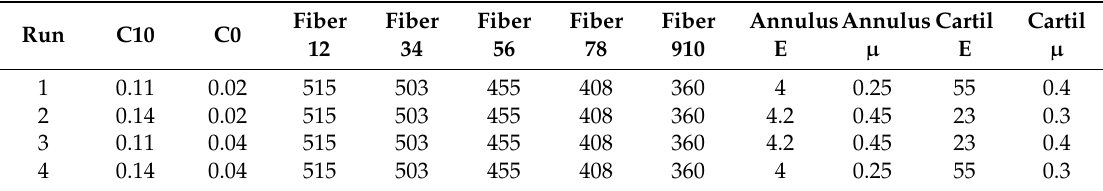
Table 9. Design matrix for the simulation of FE models when considering combination of 128 material parameters